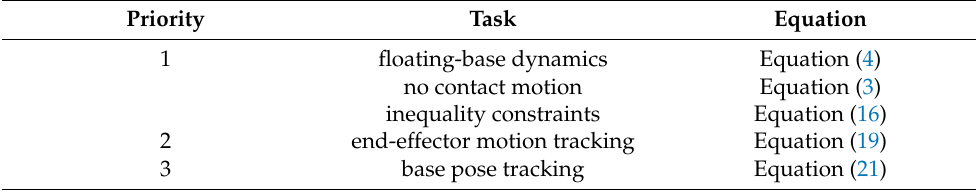
Table 1. The task priorities used in the manipulation mode of the HQP (1 is the highest priority). Priority Task Equation 1 floating-base dynamics Equation (4) no contact motion Equation (3) inequality constraints Equation (16) 2 end-effector motion tracking Equation (19) 3 base pose tracking Equation